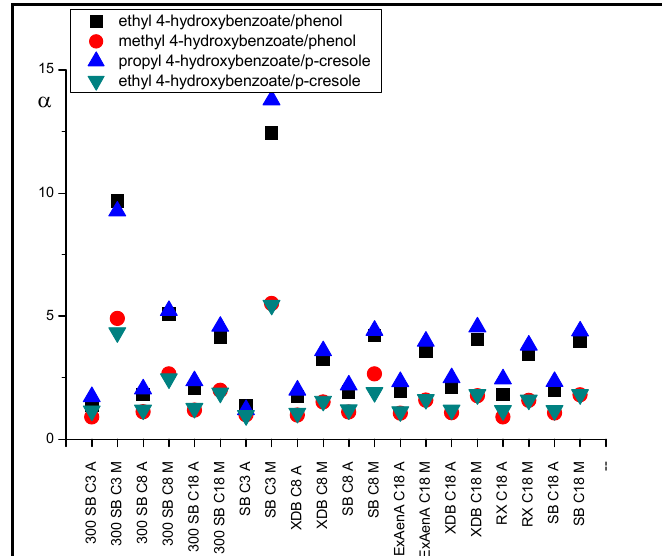
Figure 8. Separation factor, α , values of hydrocarbons with different functional groups in systems with different nonpolar stationary phases and methanol (M) in water and acetonitrile (A) in water (modifier concentrations as in Table 1).